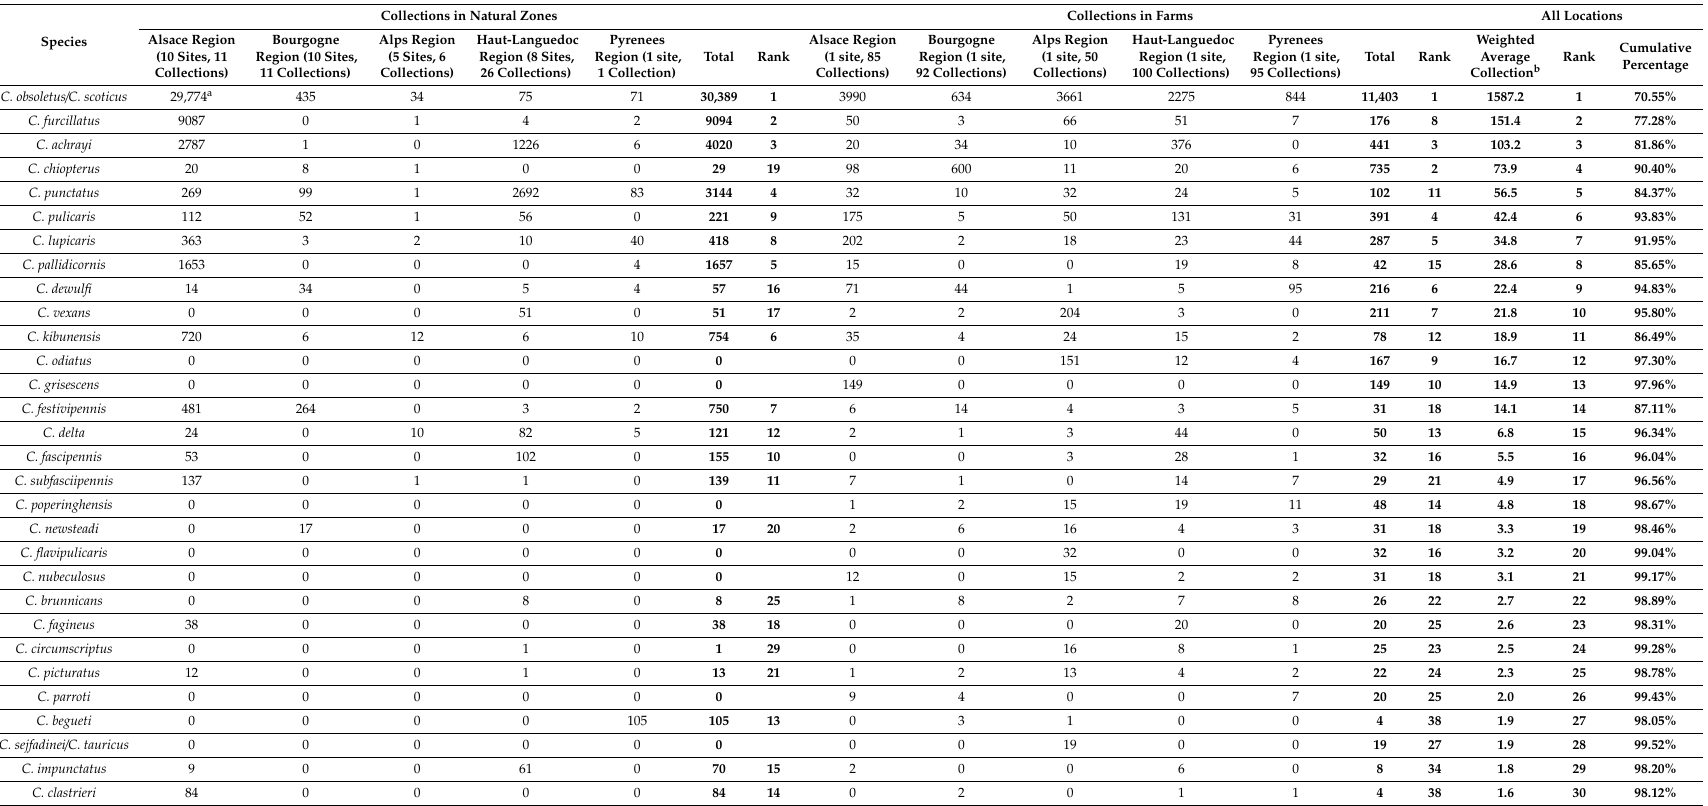
Table 4. No. Culicoides collected in natural areas (June to August 2008) and in farms (2009–2012) using UV-light suction traps (OVI model) in five di ff erent ecological and climatic French